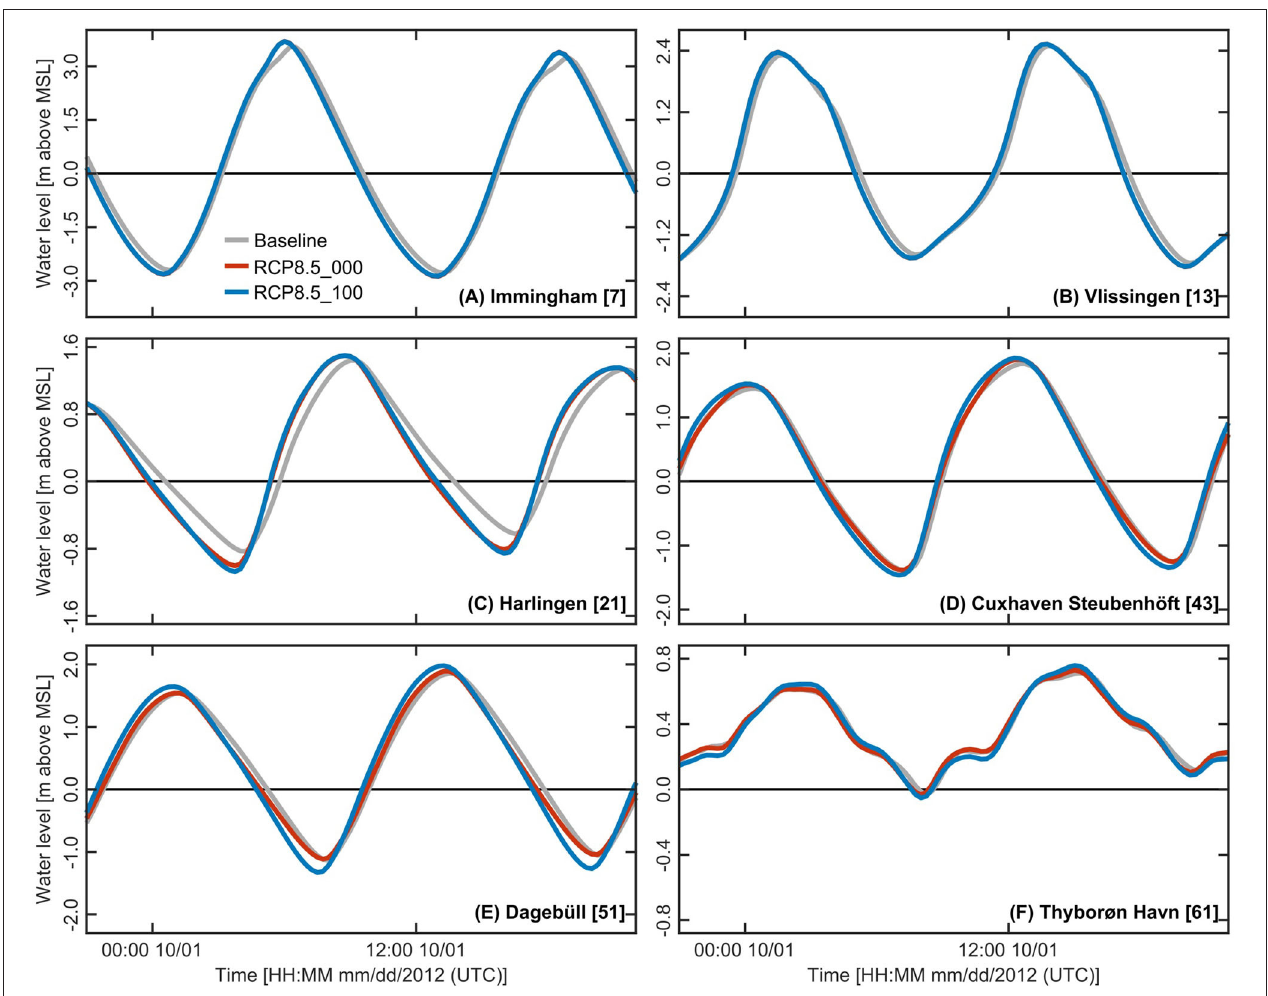
FIGURE 9 | Distortion of the tidal wave at selected tidal gauge stations resulting from combinations of 0.8m SLR projection and various cumulative rates of vertical accretion. Distortion of the tidal wave at the tidal gauge stations of (A) Immingham, (B) Vlissingen, (C) Harlingen, (D) Cuxhaven-Steubenhöft, (E) Dagebüll, and (F) Thyborøn Havn. Comparisons are based on an exemplary 25 hour period during spring tide (boundary forcing equals conditions for September 30 to October 1, 2012). Locations of tidal gauges are shown in Figure 1